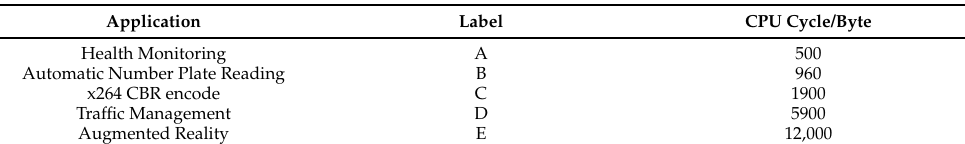
Table 3. Applications complexity [48].